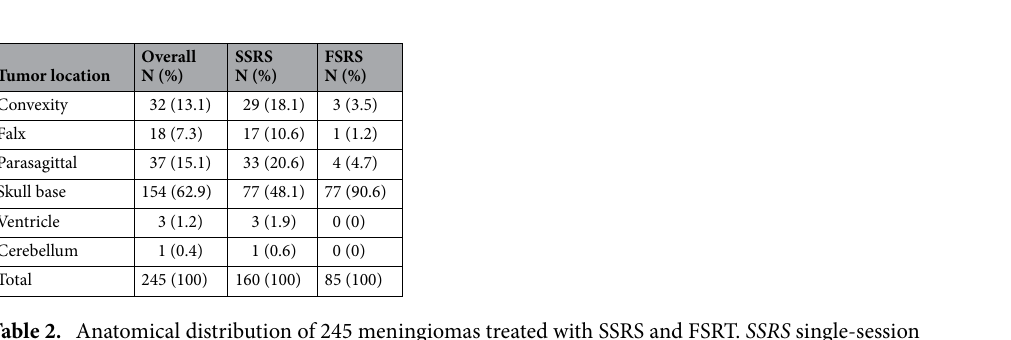
Table 2. Anatomical distribution of 245 meningiomas treated with SSRS and FSRT. SSRS single-session stereotactic radiosurgery, FSRT fractionated stereotactic